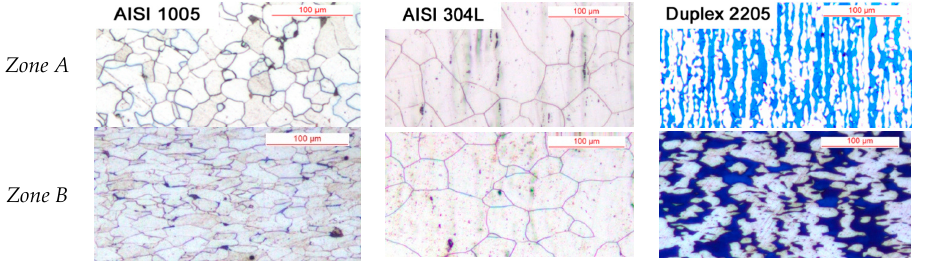
Table 2. Height reductions h at various forging